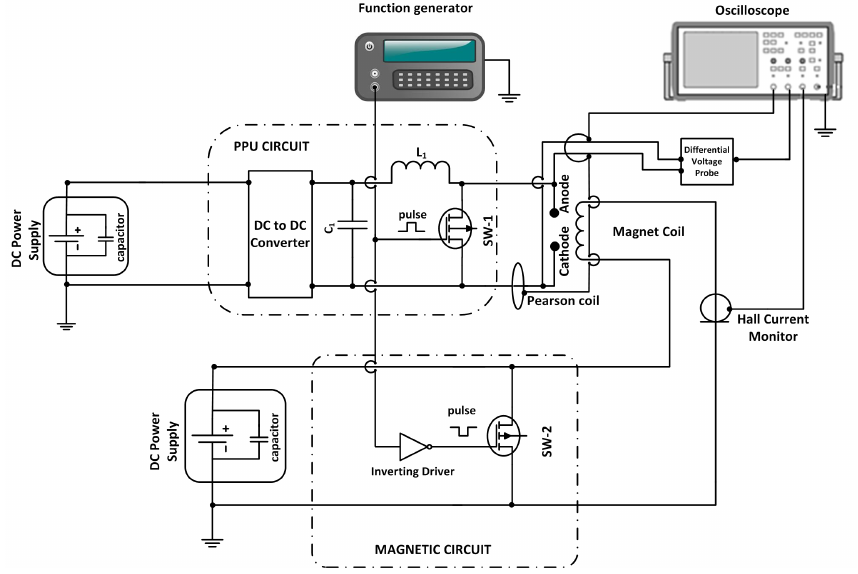
Figure 4. Schematic of the ISF-VAT circuit along with the B field generation circuit, showing external trigger